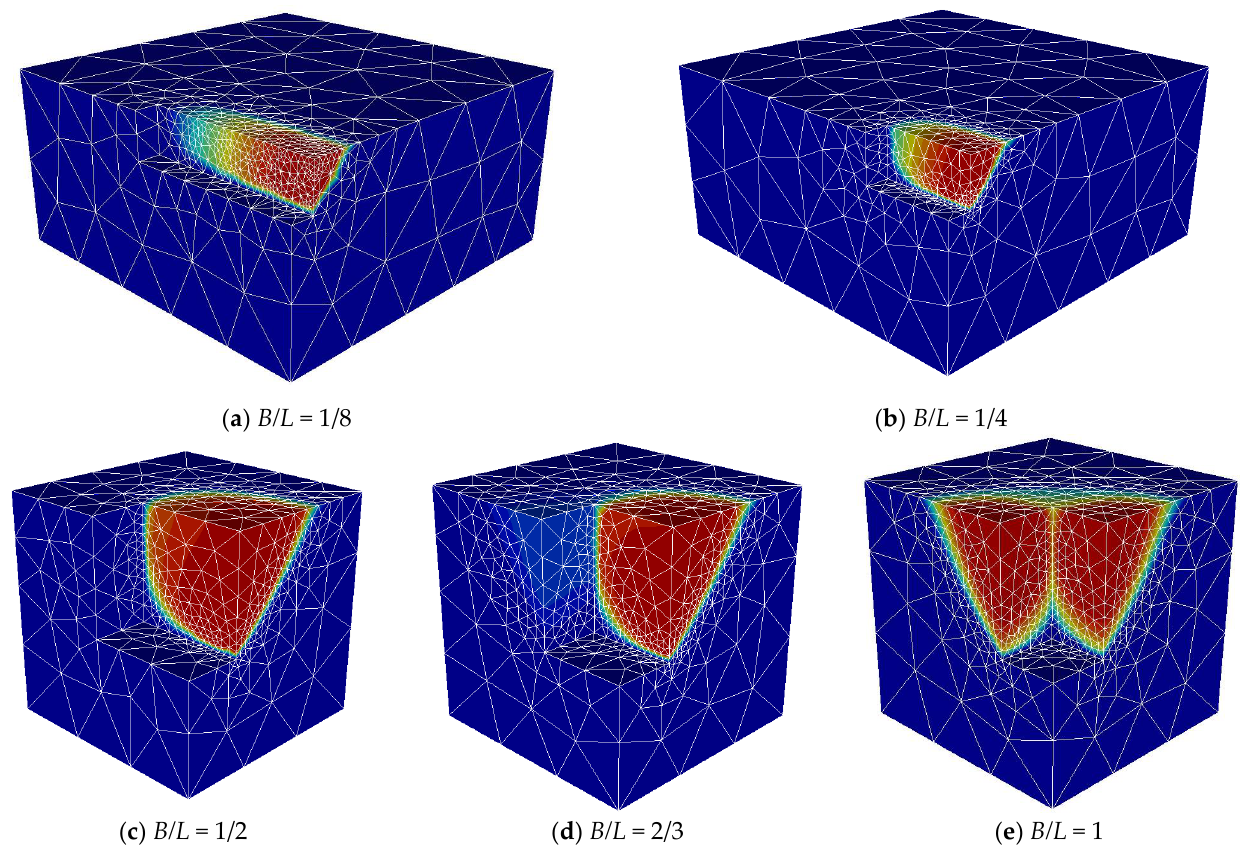
Figure 8. Potential failure mechanisms—effect of B/L ( H/B = 1, r e = 0.7, and m = 4).